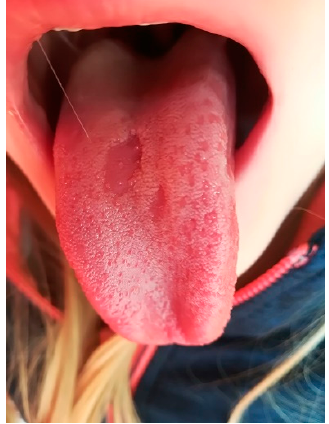
Figure 1. Geographic